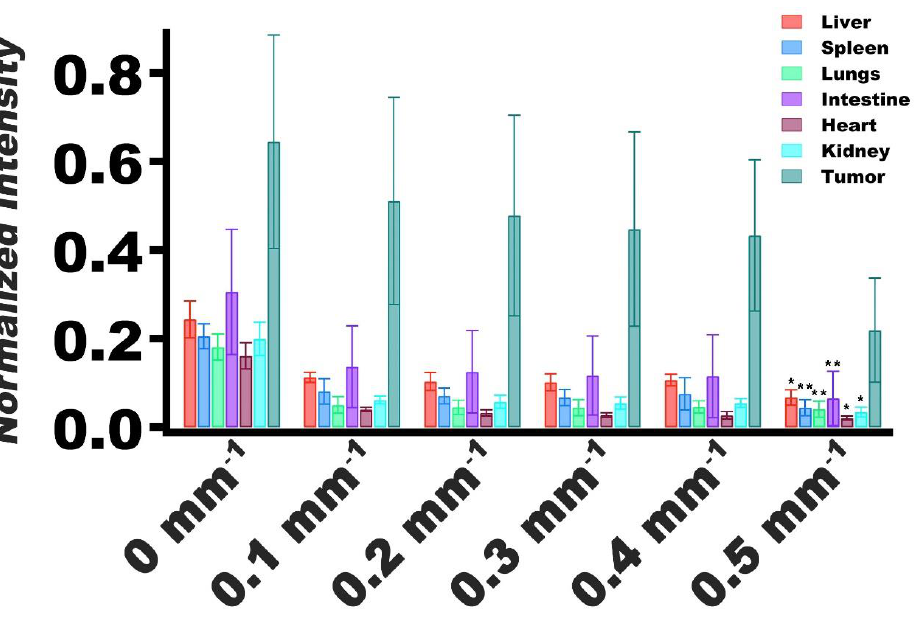
Figure 6. Normalized values of fluorescence emission intensity mean and SDs (error bars) of extracted tumors and organs ( n = 5 for each organ and tumors) for spatial frequencies of 0–0.5 mm −1 . Emission intensities were normalized by dividing the average intensity of the extracted organ or tumor by the maximum intensity of the image. Statistically significant differences in mean normalized intensity values between imaging at f x = 0.5 mm −1 and f x = 0.1 mm −1 are shown by asterisks with * indicating p < 0.05, and ** indicating p <